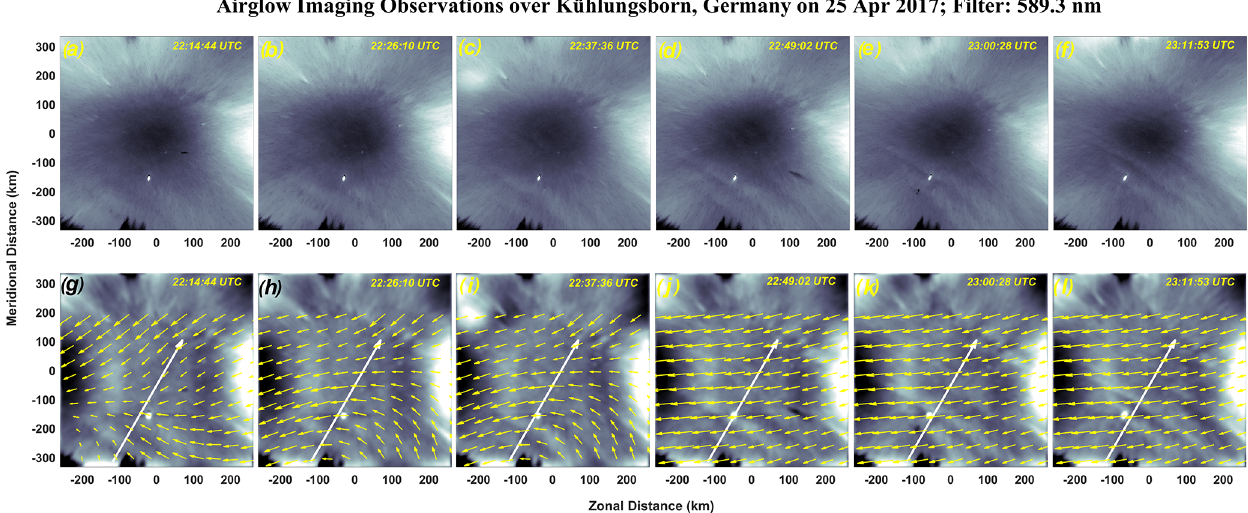
Figure 4. (a–f) Sequence of Na 589.3nm airglow images on 25 April 2017 over northern Germany. (g–l) Corresponding 2D FFT filtered images overlaid on horizontal variation of wind field (yellow arrows) at the emission centroid height (91km) measured by MMARIA. The white arrow denotes the wave vector.